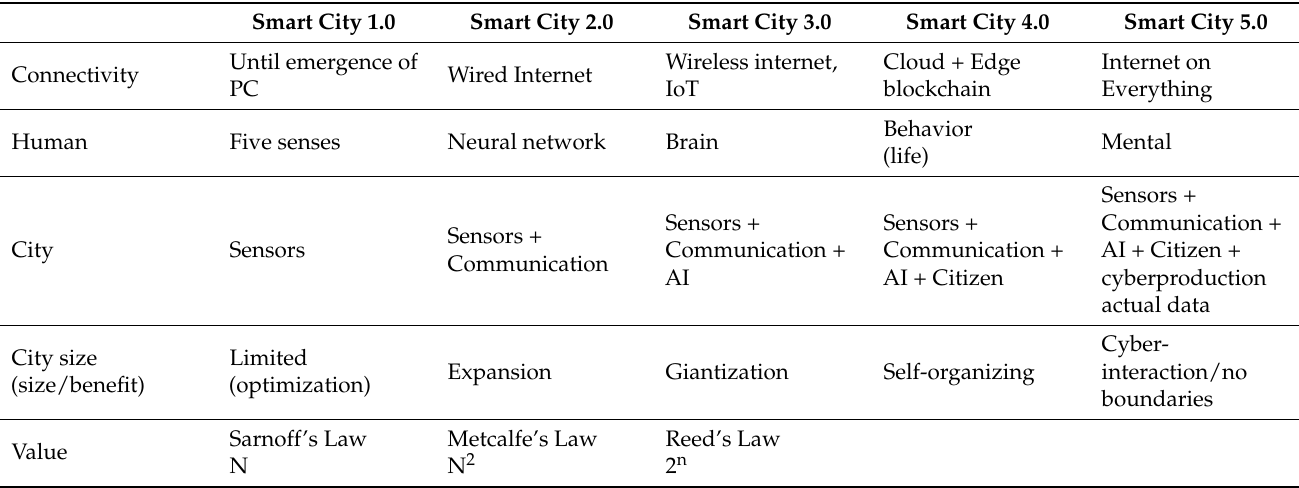
Table 2. Smart city concepts (summary) 2018 – 2022.